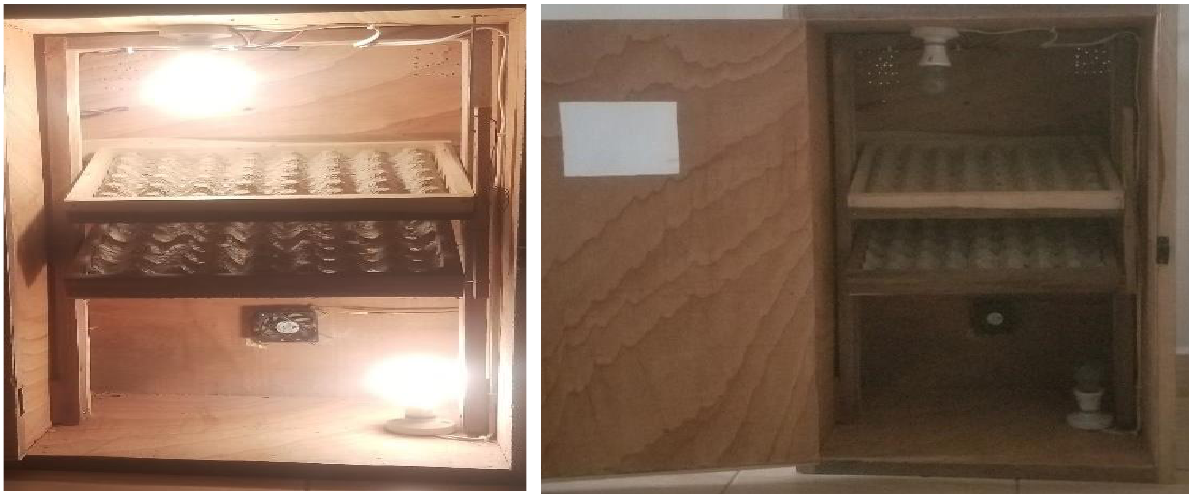
Figure 14. Opened Incubator with light on Figure 15. Opened incubator with light